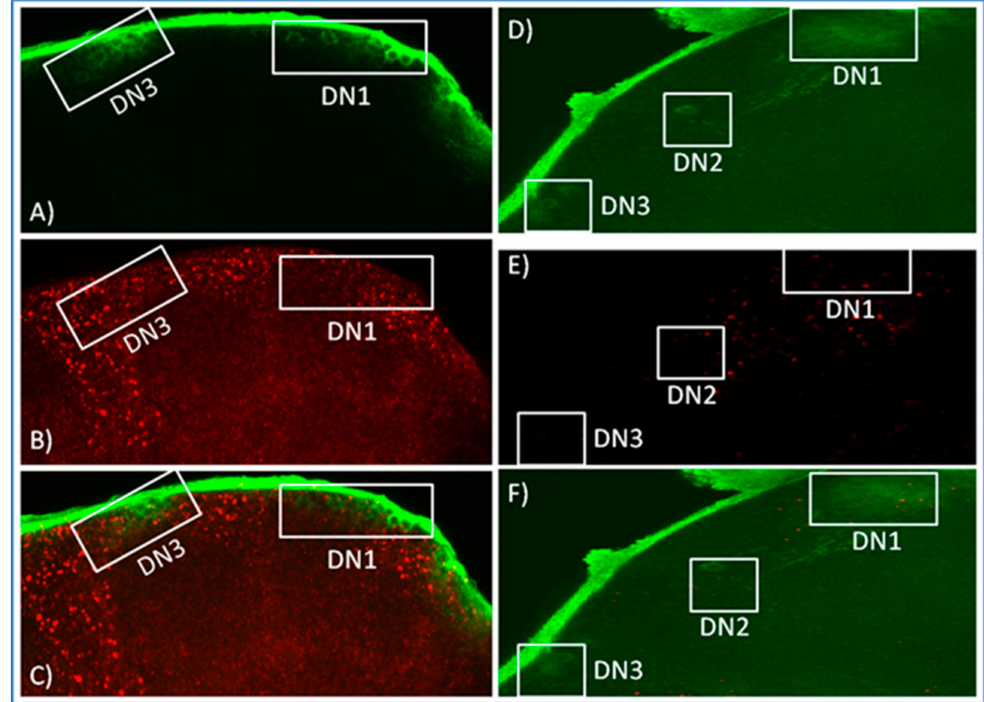
Figure 3. In situ hybridisation. Dorsal views of representative R32 adult brains probed with α -LACZ antibody (( A , D ), green), antisense norpA probe (concentrated 75 ng, ( B ), red) and sense norpA probe (concentrated 150 ng, ( E ), red). ( C ) and ( F ) are a merge of ( A , B ) and ( D , E ), respectively. The brains presented are images of 10 independent layers merged